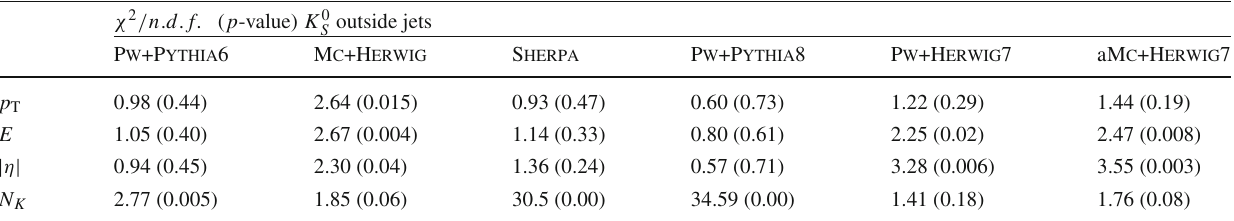
Table 9 Values of the χ 2 per degree of freedom and their corresponding p -values, for K 0 MC@NLO + Herwig , Sherpa , Powheg + Pythia8 , Powheg + Herwig7 and a MC@NLO + Herwig7